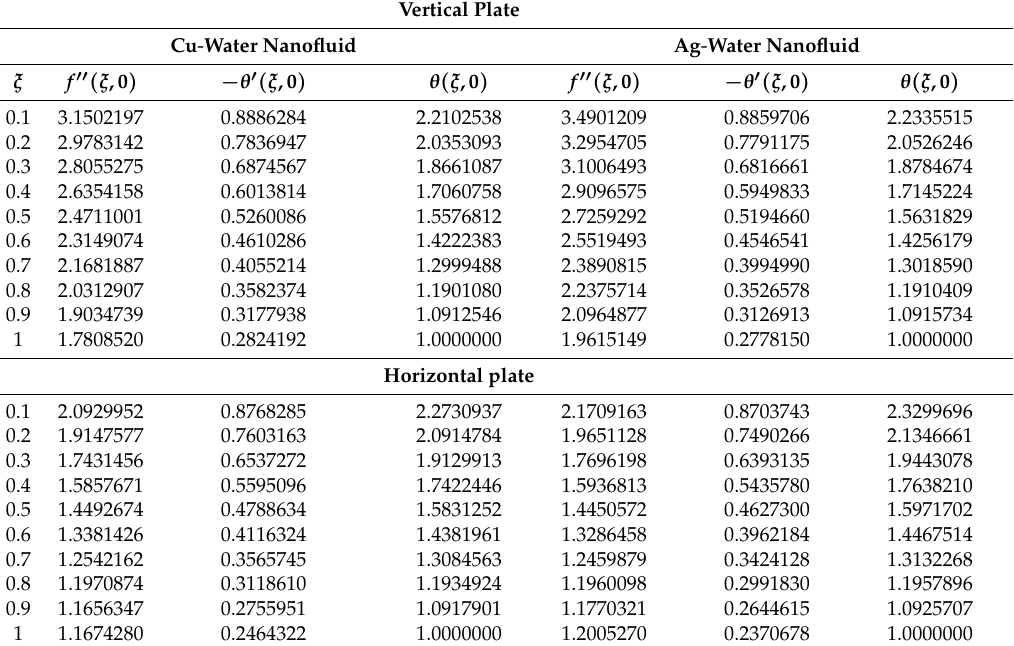
Table 3. OMD-BSQLM results for the skin friction coefficient, heat transfer rate and surface temperature at different values of ξ when Pr = 0.7, φ = 0.3, M = 0.5, Q = 0.01 and Rd =